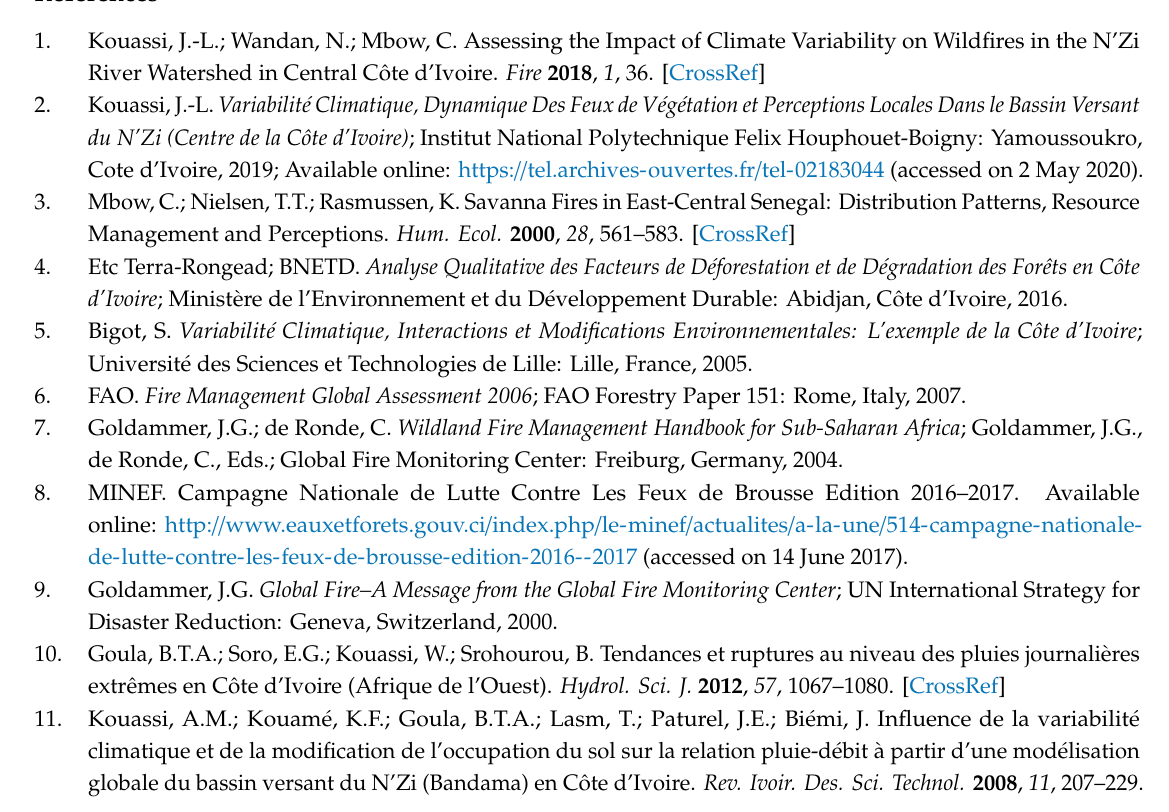
Figure S1: Monthly wildfire occurrence in the (a) forest zone, (b) pre-forest zone, (c) Sudanian zone, and (d) whole NRW. Figure S2: Monthly burnt areas in the (a) forest zone, (b) pre-forest zone, (c) Sudanian zone, and (d) whole NRW. Figure S3: Annual wildfire occurrence in the (a) forest zone, (b) pre-forest zone, (c) Sudanian zone, and (d) whole NRW. Figure S4: Annual burnt areas in the (a) forest zone, (b) pre-forest zone, (c) Sudanian zone, and (d) whole NRW. Figure S5: Residual plots of the fitted SARIMA models of the number of wildfires in the (a) forest zone, (b) pre-forest zone, (c) Sudanian zone, and (d) whole NRW. Figure S6: Residual plots of the fitted SARIMA models of burnt areas in the (a) forest zone, (b) pre-forest zone, (c) Sudanian zone, and (d) whole